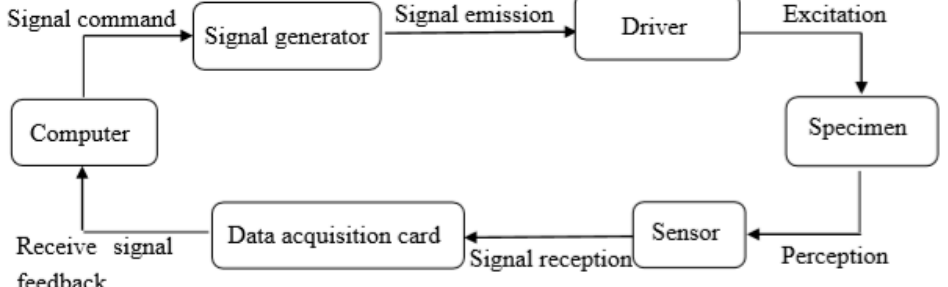
Figure 1. Block diagram of health monitoring system based on wave method.